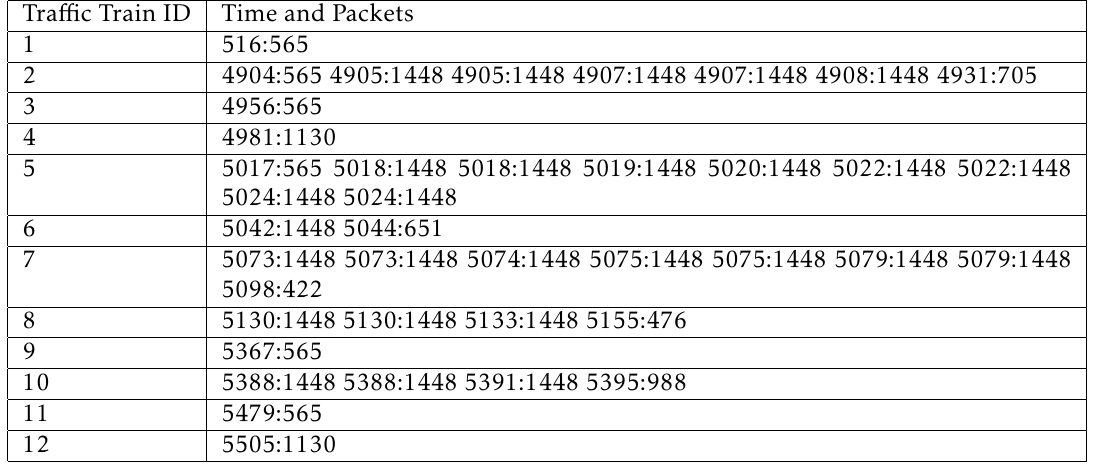
Table 3. The parsed incoming traffic train